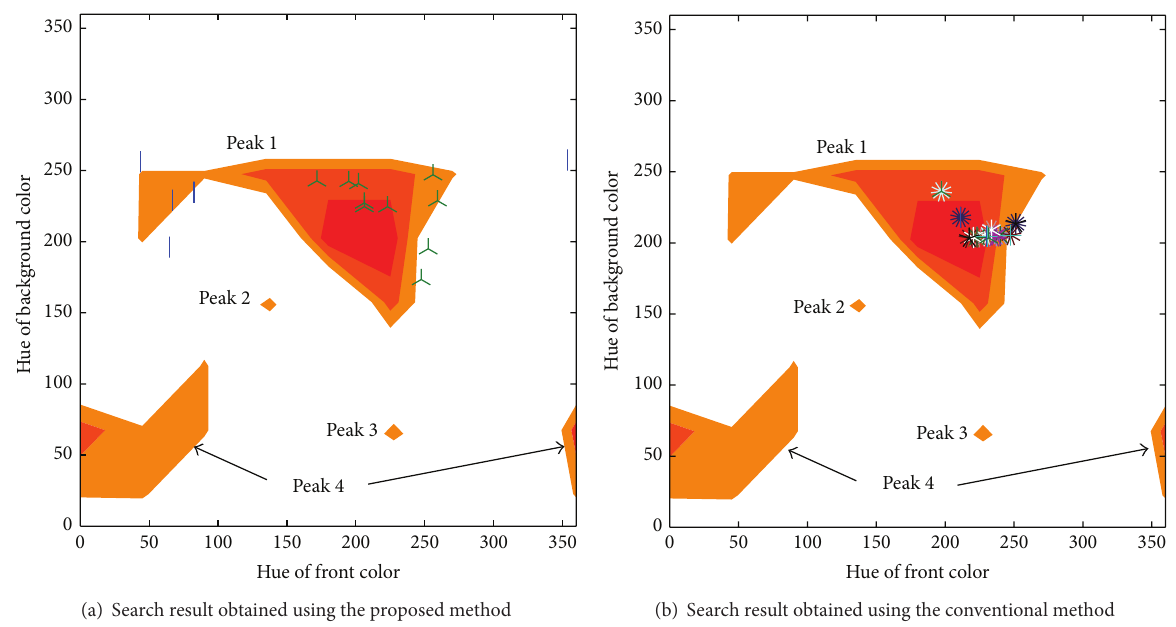
Figure 20: Examples of search results for landscapes containing 4 peaks (for arabesque